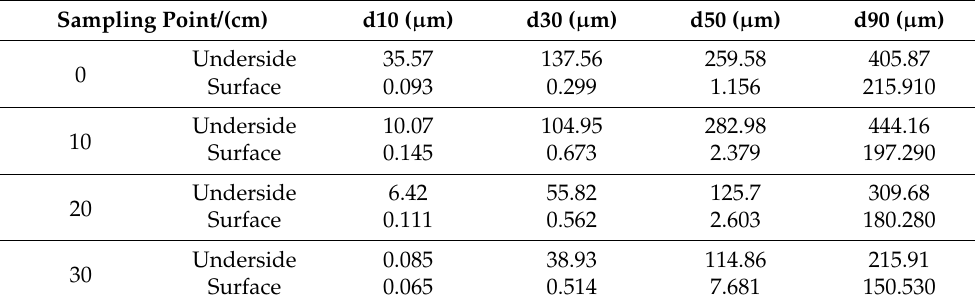
Table 2. Particle size distribution in the first layer.